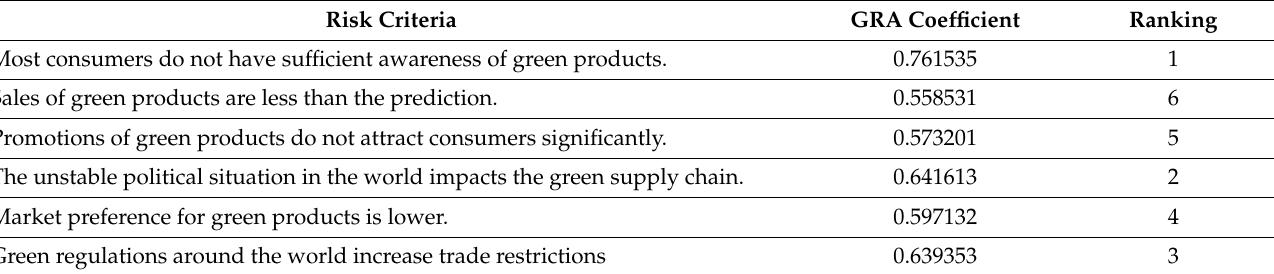
Table 8. The ranking of the green criteria in the green